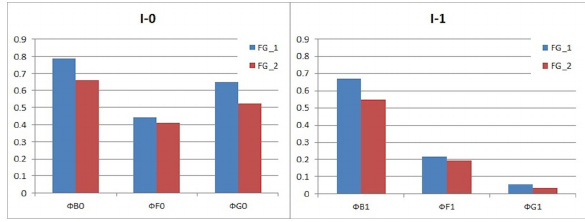
Figure 7: Safety factors in-service and operation states of the joint gasketed with two configurations –FG_1 and FG _2 materials